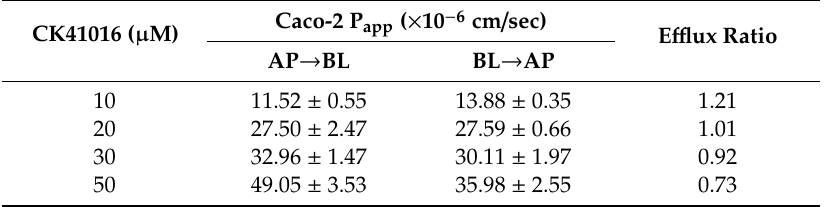
Table 4. Permeability and e ffl ux ratio of CK41016 in Caco-2 cell